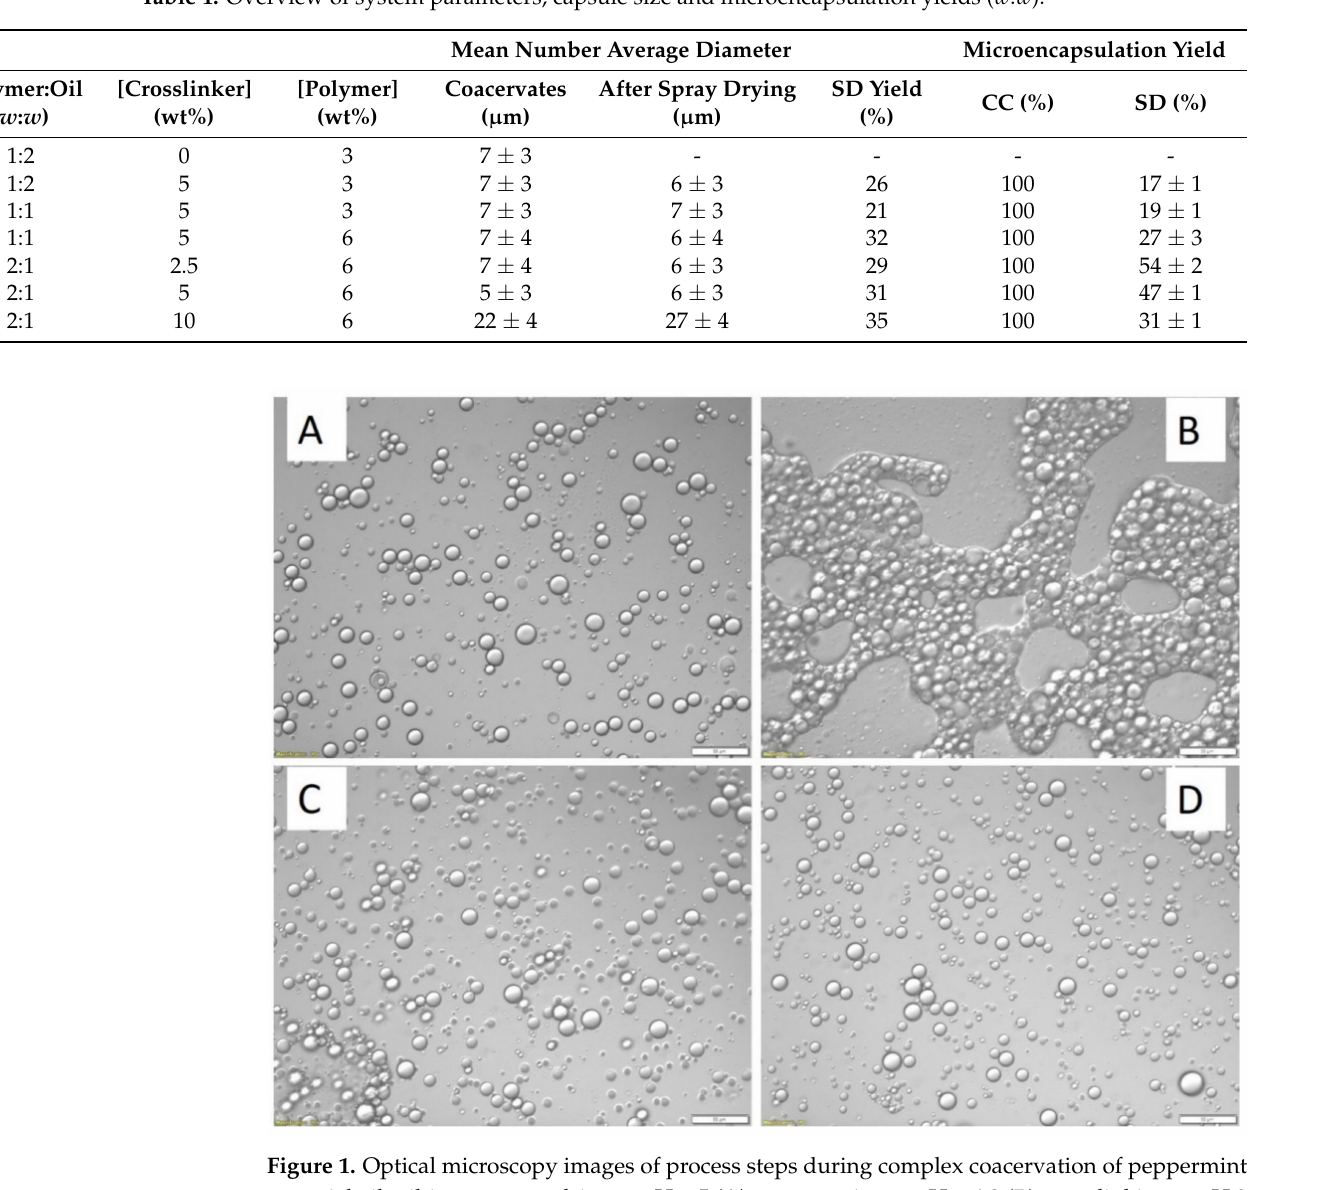
Table 1. Overview of system parameters, capsule size and microencapsulation yields ( w : w ).